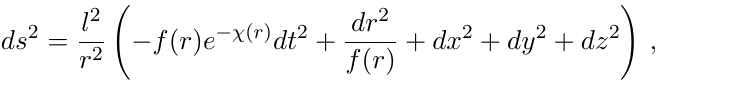
JHEP04(2022)167